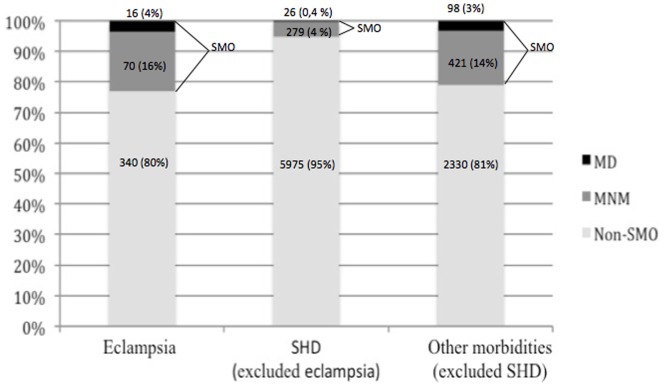
Distribution of Non-SMO, MNM and MD in women with eclampsia, others SHD and other morbidities [Non-SMO = women without severe maternal outcomes (MNM or MD), SMO = Severe maternal outcome (MNM = maternal near miss or MD = maternal death), SHD = severe hypertensive disorders].